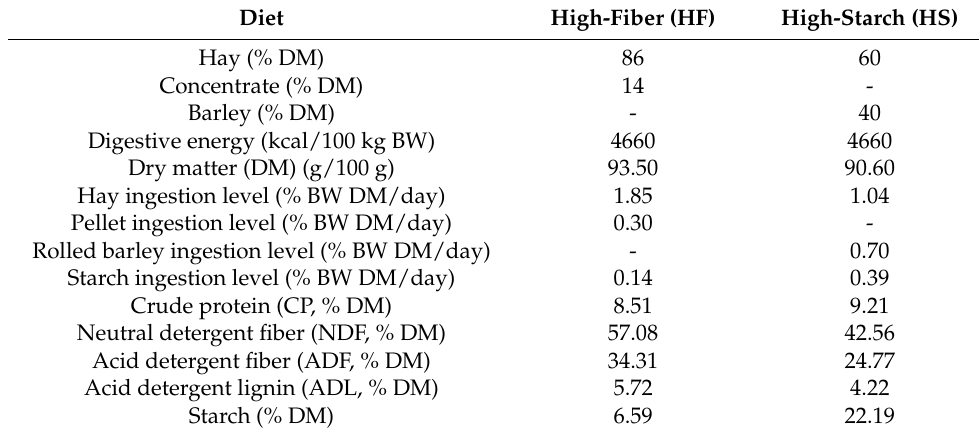
Figure 1. Diagram depicting the timing of the dietary changes from high-fiber (HF) to high-starch (HS) and vice versa, days (D) of sample collections (black cross), and the administration of feed supplement. Table 1. Chemical and nutritional composition of the